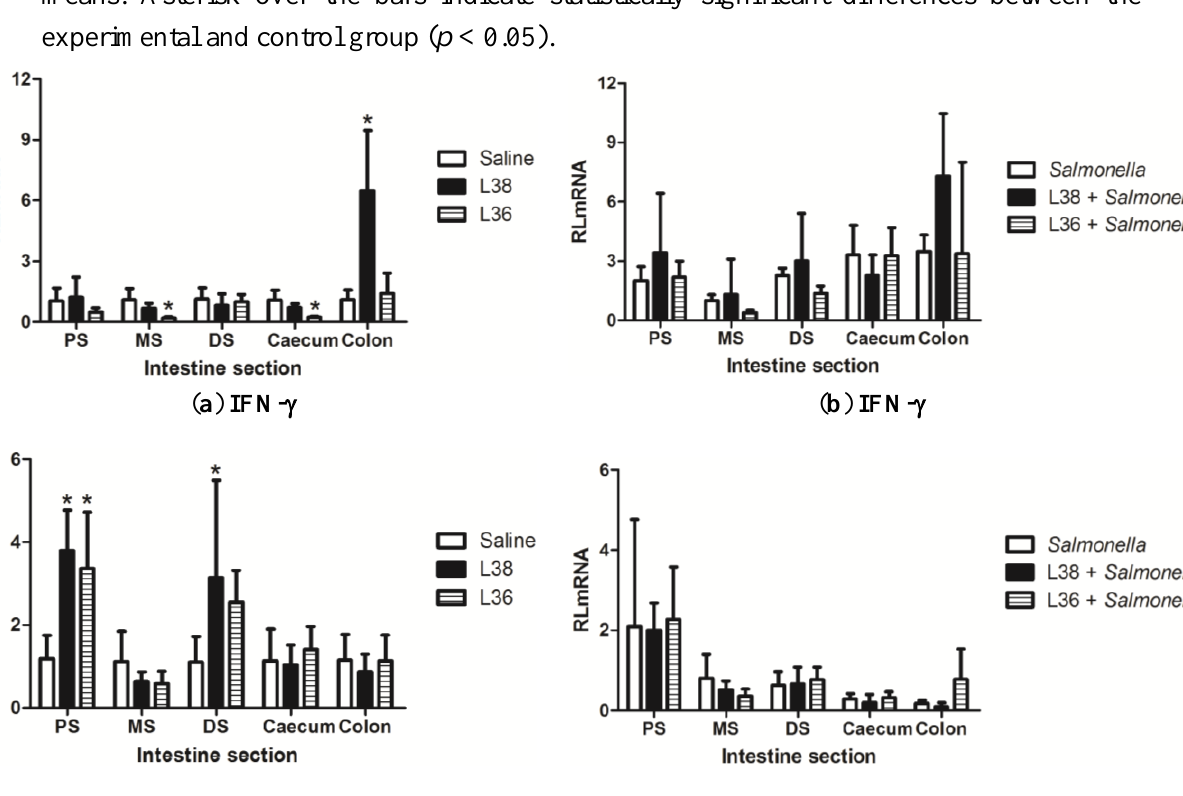
post -Salmonella challenge. ( a , b ) IFN-  ; ( c , d ) IL5; ( e , f ) IL6; ( g , h ) IL10; ( i , j ) IL12; ( k , l ) IL17; ( m , n ) TGF-  ; ( o , p ) TNF-  . Data were expressed as relative mean of